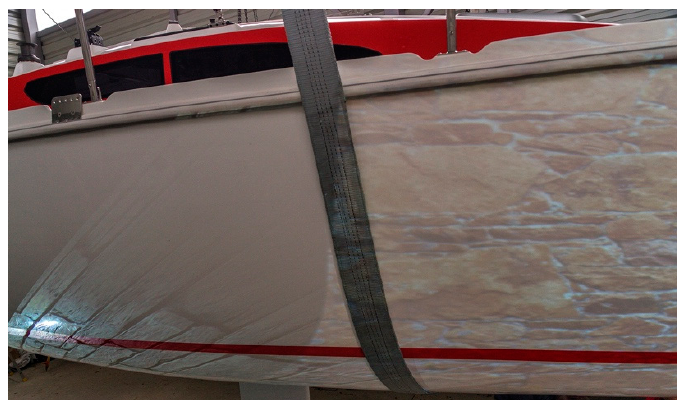
Figure 10. Detail of the suspension system using hanging straps for placing the sailboat to the appropriate height.